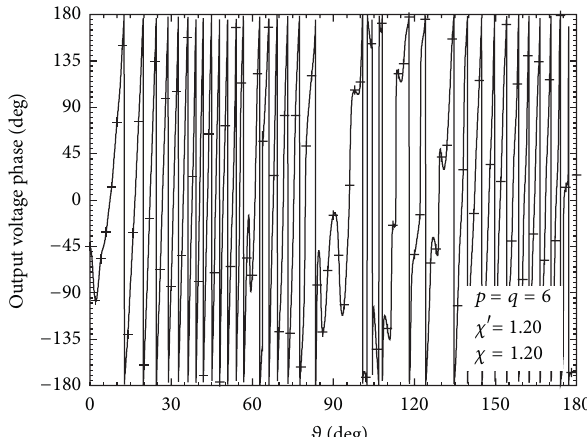
Figure 9: Phase of the probe voltage 𝑉 on the meridian at 𝜑 = 0 ∘ . Solid line: exact. Crosses: interpolated.